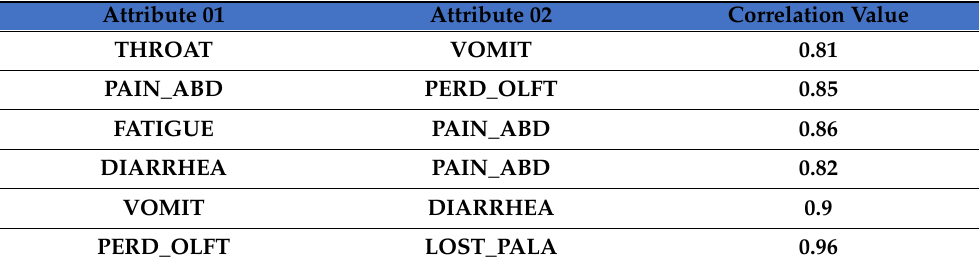
Figure 3. Correlation. Table 2. Positive correlation. Table 2. Positive correlation.